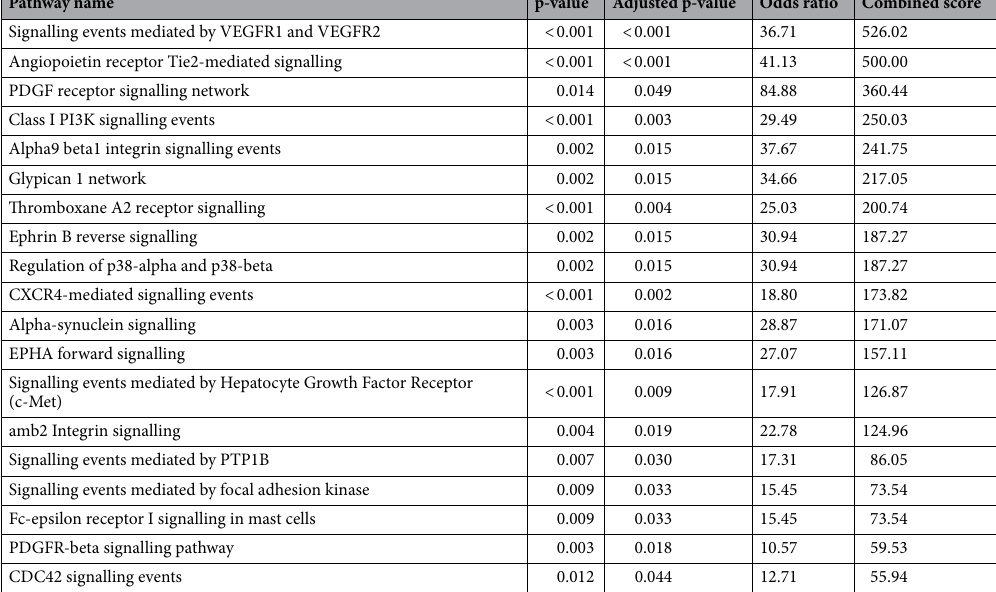
Table 5. Pathway analysis by Enrichr/NCI Nature 2016. Proteins that correlated with PC1 and/or PC2 and which were positive differentially expressed proteins among patients with sepsis-AKI as compared to patients without AKI. The proteins were used to identify pathways affected by sepsis-AKI, only pathways with an adjusted p-value < 0.05 are